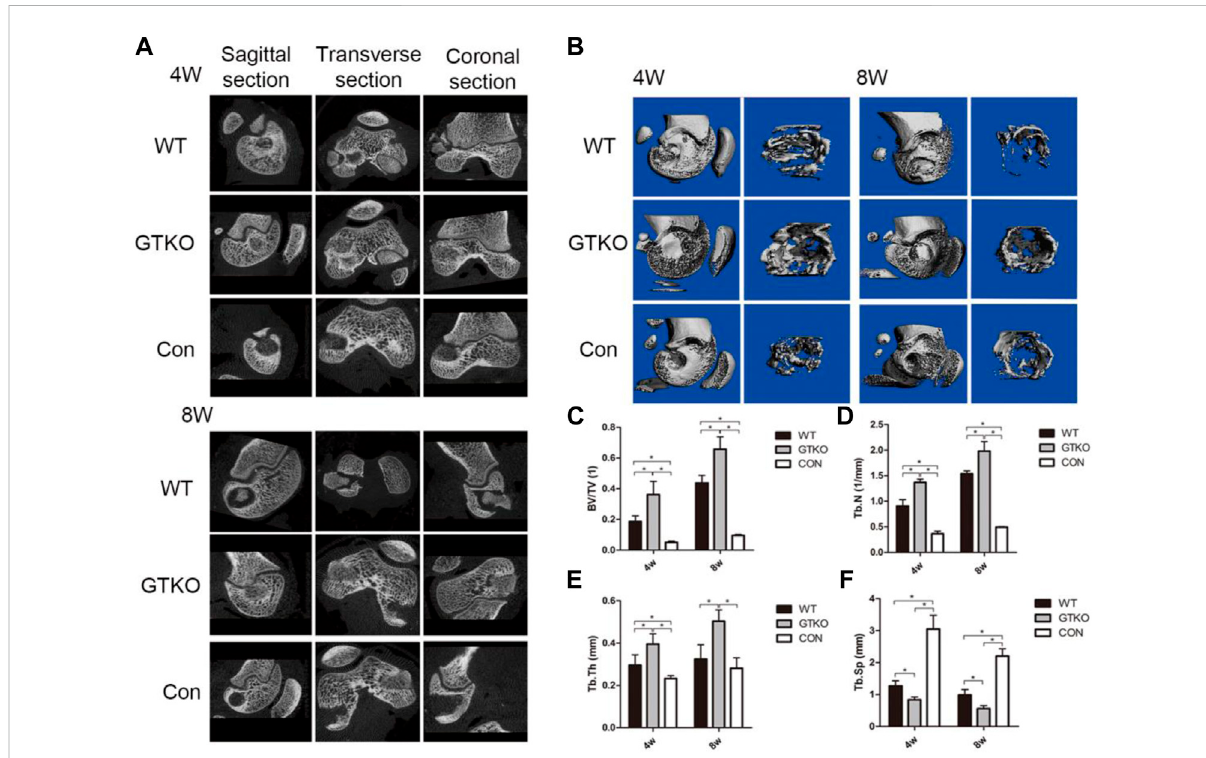
FIGURE 2 Two-dimensional reconstruction of micro-CT scan. (A) Axial, coronal and sagittal reconstruction at 4 and 8 weeks after surgery. (B) Three- dimensional reconstruction of a micro-CT scan of the whole femoral condyle and VOI (×2.5) at different time-points after the surgery. (C) Statistical analysisoftheVOIofthebonedefectsshowingthebonevolumefractionbymicro-CTatdifferenttime-pointsaftersurgery; (D) Statisticalanalysisof the VOI of the bone defect showing trabecular number by micro-CT at different time-points after surgery; (E) Statistical analysis of the VOI of thebone defect showing trabecular thickness by micro-CT atdifferenttime-pointsafter surgery; (F) StatisticalanalysisoftheVOIofthebone defect trabecular separation by micro-CT at different time-points after surgery. Data are shown as mean ± SD.* p < 0.05. VOI, volume of interest; BV/TV, trabecular bone volume fraction; Tb. Th, trabecular thickness; Tb. N, trabecular number; Tb. Sp, trabecular